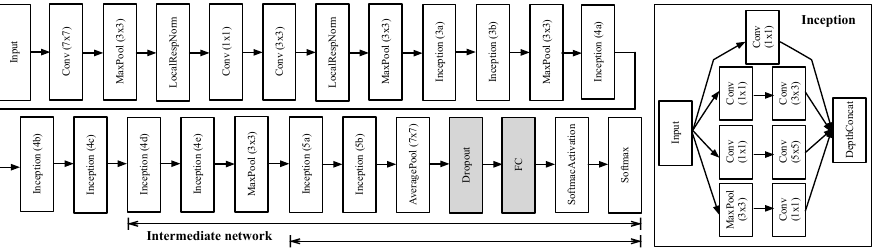
Figure 2. GoogLeNet architecture. Conv and FC denote the convolutional layer and the fully- connected layer while MaxPool and AveragePool are the max pooling layer and average pooling layer, respectively; ( a × b ) means the filter size of the convolutional layer or the pooling size of the pooling layer, respectively. We add the dropout layer after the last average pooling